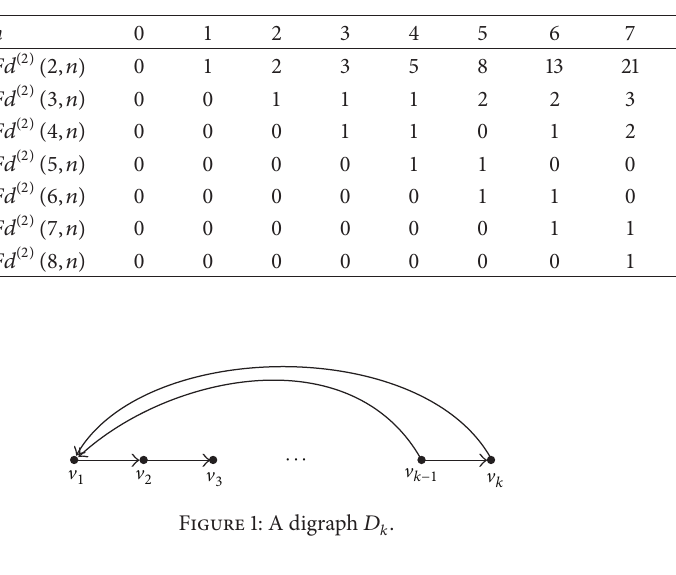
Table 2: The 𝑛 th distance Fibonacci numbers 𝐹𝑑 (2) (𝑘,𝑛) .